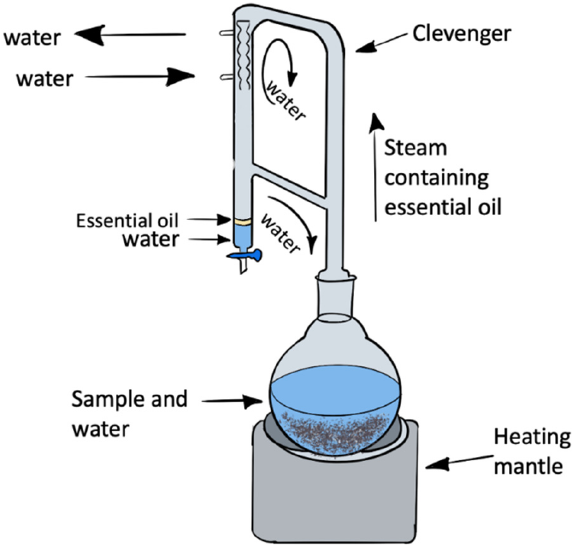
Figure 6. Clevenger apparatus for hydrodistillation (This figure was made with Procreate 5.2).